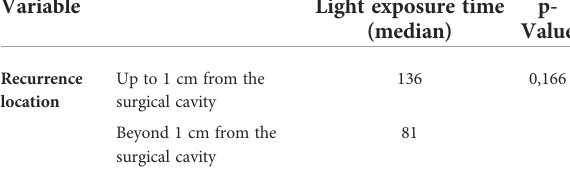
TABLE 3 Univariate analysis. Variable Recurrence location